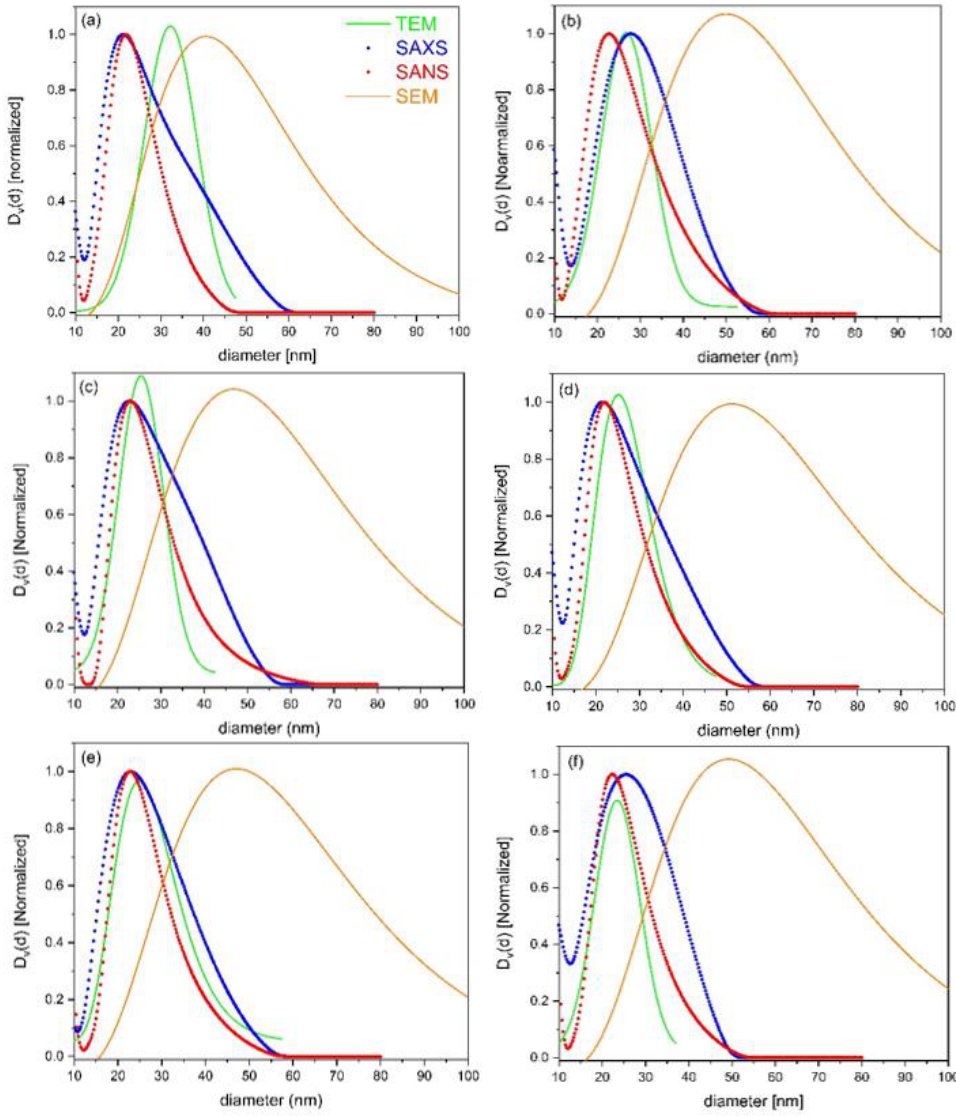
Figure 6. Comparison of the volume-normalized size distributions derived from SANS (red circles), SAXS (blue circles), TEM (green lines), and SEM (orange lines) for six different samples. ( a ) Sample #1, ( b ) sample #7, ( c ) sample #10, ( d ) sample #13, ( e ) sample #17, and ( f ) sample #21.